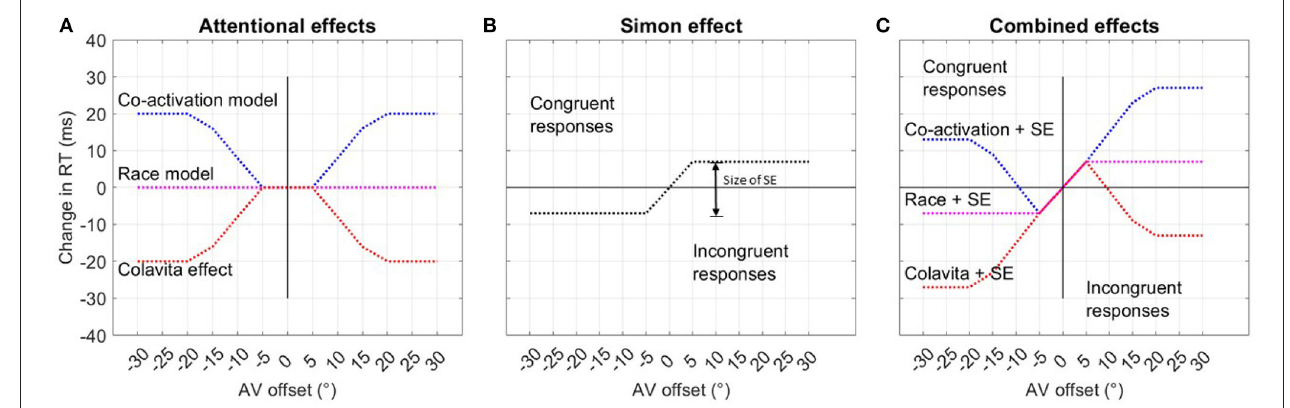
FIGURE 3 | Hypothesis assuming the existence of two separate effects influencing RTs. (A) The first graph shows the assumed even, or axis symmetric effect of spatial attention on RTs, differentiating between the co-activation, race, and Colavita models. (B) The second graph depicts the odd, or point-symmetric course of RTs due to the Simon effect (SE) for spatially congruent and incongruent responses. The size of the Simon effect is given as the difference in response time between congruent and incongruent responses. (C) The last graph summarizes both effects and the expected RT over offset when congruent are summarized under negative offset values and incongruent responses under positive offset